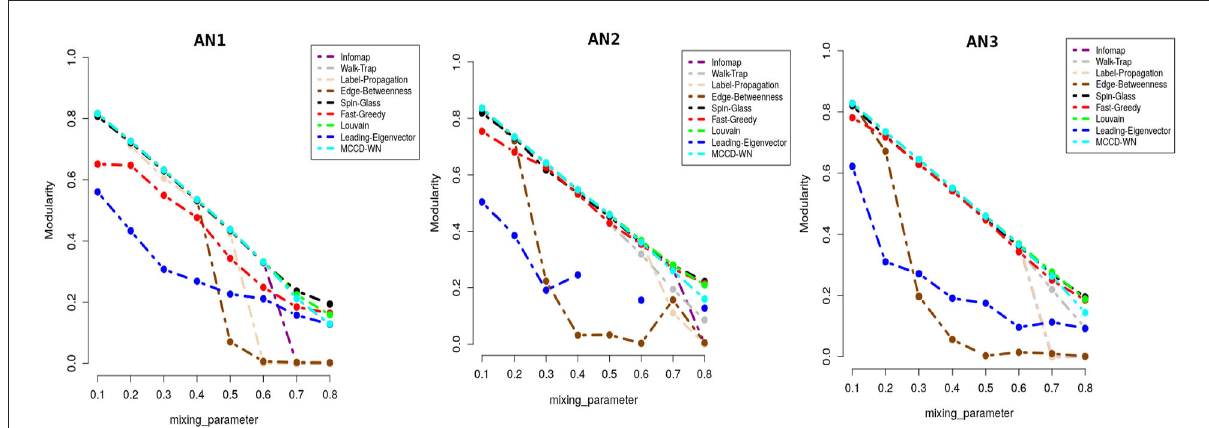
FIGURE6 Performance comparison in terms of modularity